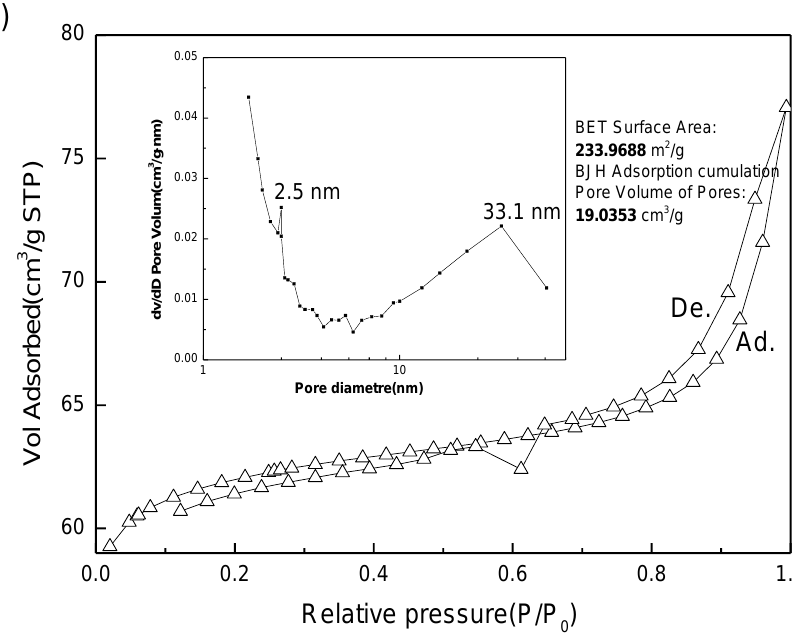
Figure 2. SEM images ( A ) and XRD spectra ( B ) of permutite with different treatments; (a) Untreated, (b) 0.1 mol Ag + , (c) 0.1 mol Zn 2+ , (d) 0.1 mol Ag + and 0.1 mol Zn 2+ ; Nitrogen sorption isotherms of permutite samples; ( C ) permutite, ( D ) Ag + /Zn 2+ -permutite.